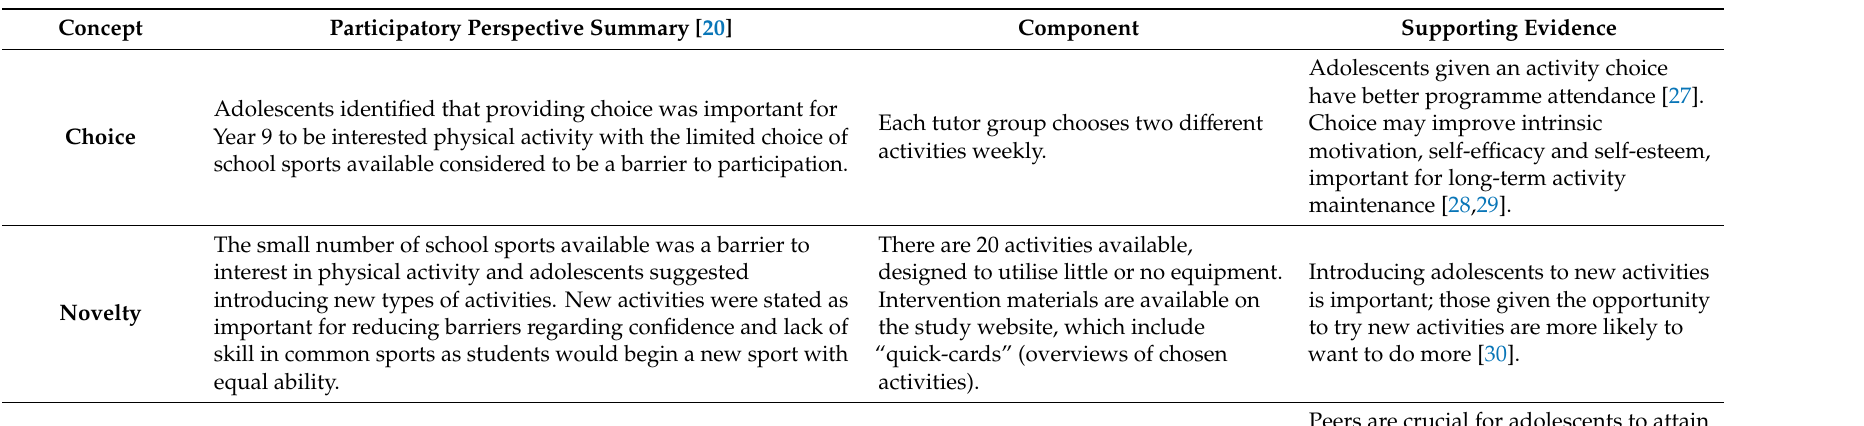
Table 1. Intervention components of the GoActive intervention with rationale from participatory development